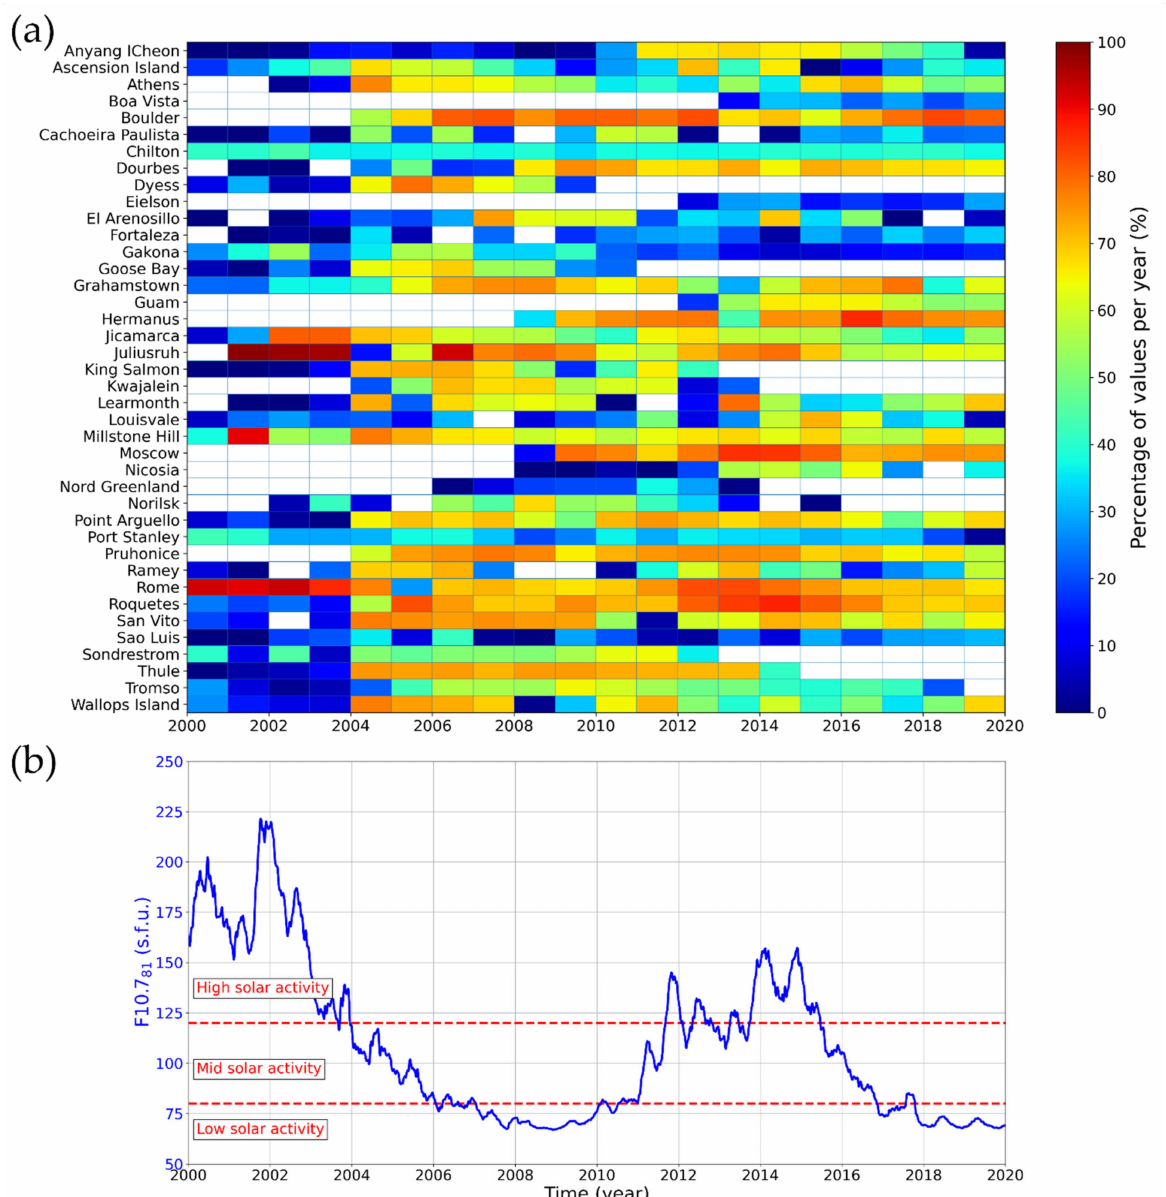
Figure 2. ( a ) Percentage of available ionosonde observations per year and ionosonde station. ( b ) F10.7 81 time series from 2000 to 2019. Red horizontal dashed lines identify the three ranges chosen for the solar activity